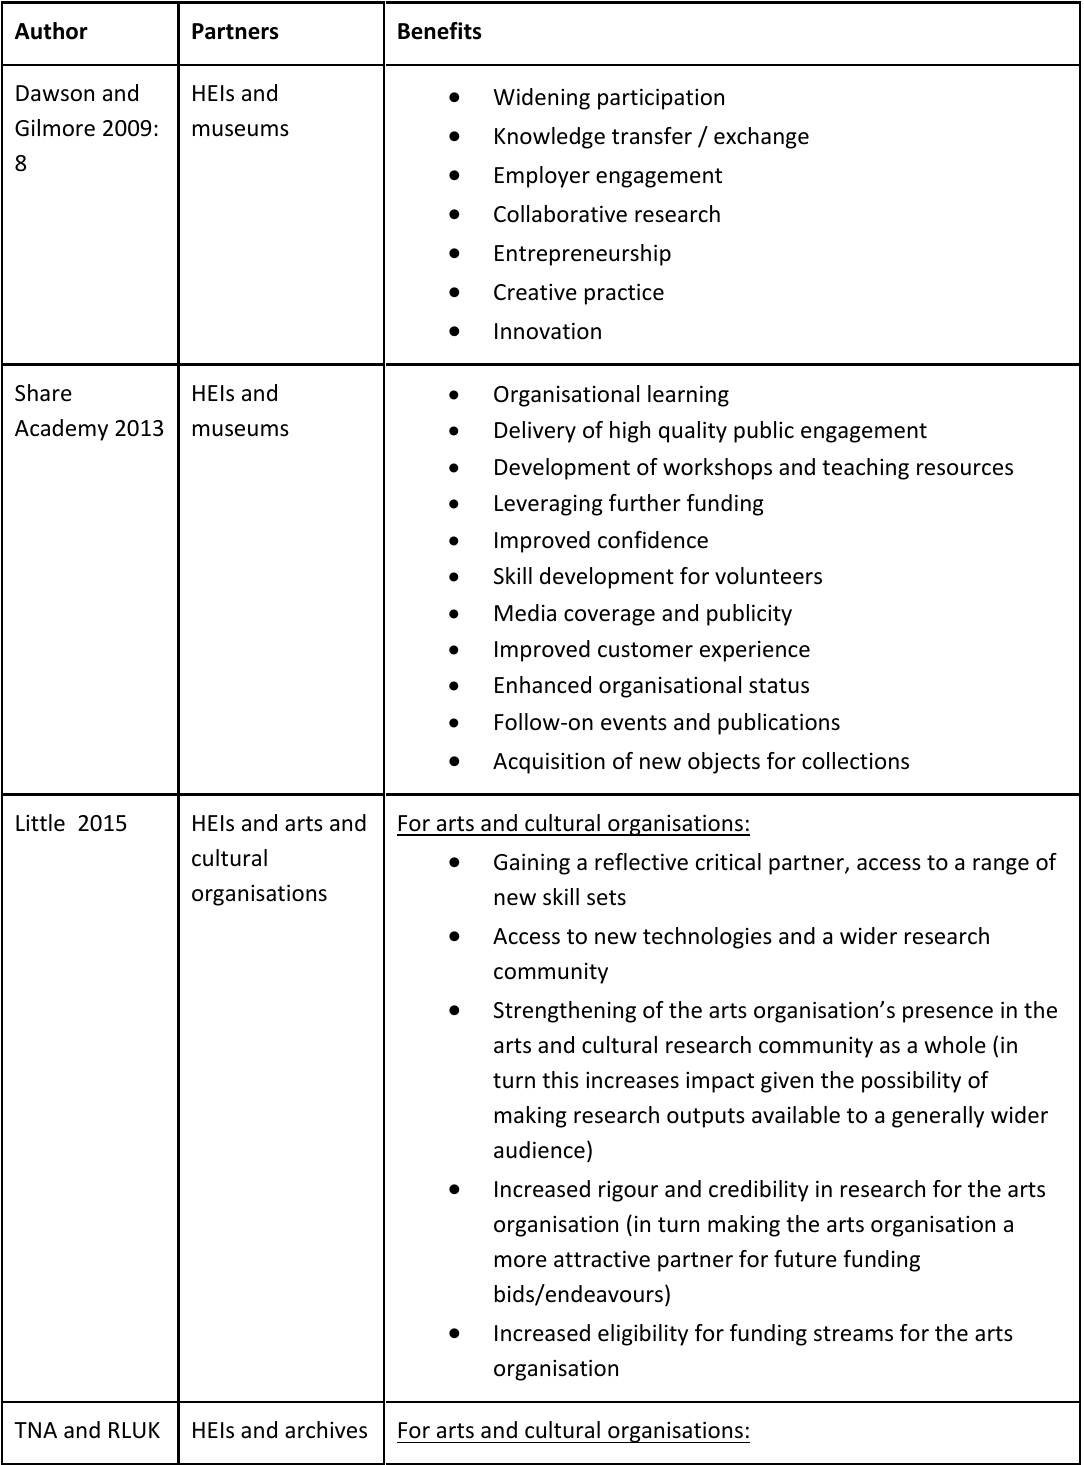
Table 4. Benefits deriving from partnerships between universities and cultural organisations including